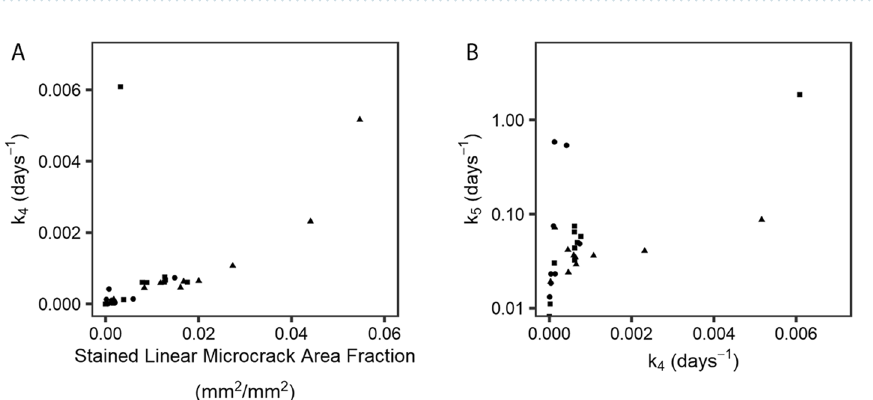
Figure 3. Non-damaged ROI (open symbols) and damaged ROI (filled symbols) solutions. ( A ) Undamaged resorption rate ( k 1 ) shown against measured bone volume fraction, ( B) k 1 shown against measured tissue mineral density, ( C) osteoid formation rate ( k 2 ) shown against measured bone volume fraction, ( D) k 2 shown against measured tissue mineral density. In all panels, data from FX PSB (triangle) CLI PSBs (square) and CTRL PSBs (circles) are shown.